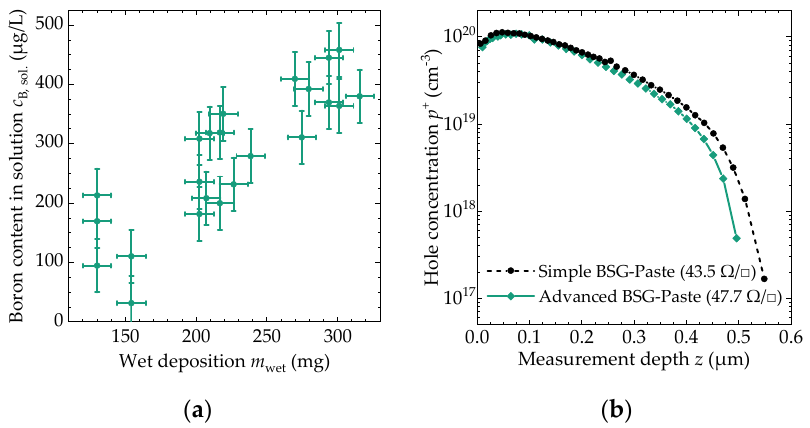
Figure 3. Dopant analysis of the thin films obtained. ( a ) Boron content c B,sol determined after dissolution as a function of the amount of paste transferred to the wafer m wet ; ( b ) hole concentration p + near the surface of a printed wafer as a function of measurement depth z after thermal treatment at a temperature of 950 °C. In the legend, the sheet resistance R □ of the doped layer is given in brackets.